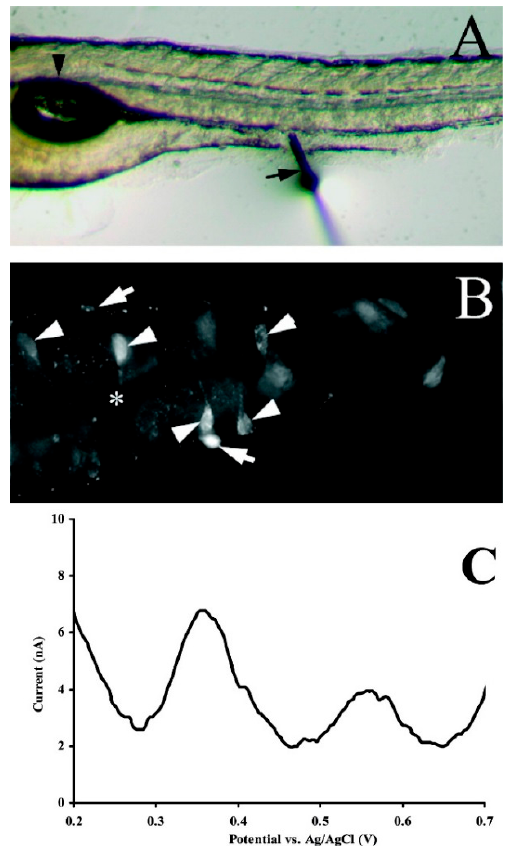
Figure 11. ( A ) Insertion of the electrochemical microsensor into the intact embryonic intestine between the posterior swim bladder and the end of the intestine at 5 dpf. The arrowhead indicates the swim bladder and the arrow shows the point of insertion of the microelectrodes. ( B ) 5-HT immunohistochemistry reveals a subset of enteric neurons (arrows), as well as enterochromaffin cells within the epithelium (arrowheads). Enteric neurons are on the periphery of the intestine between the thin circular and longitudinal smooth muscle layers. Enterochromaffin cells, which are situated more toward the basal surface of the epithelium, sense the contents of the lumen (asterisk) using thin processes. ( C ) Typical differential pulse voltammogram obtained in vivo with the implanted microelectrode as shown in ( A ). The supporting electrolyte was E3 medium [134]. Copyright 2010, American Chemical Society.